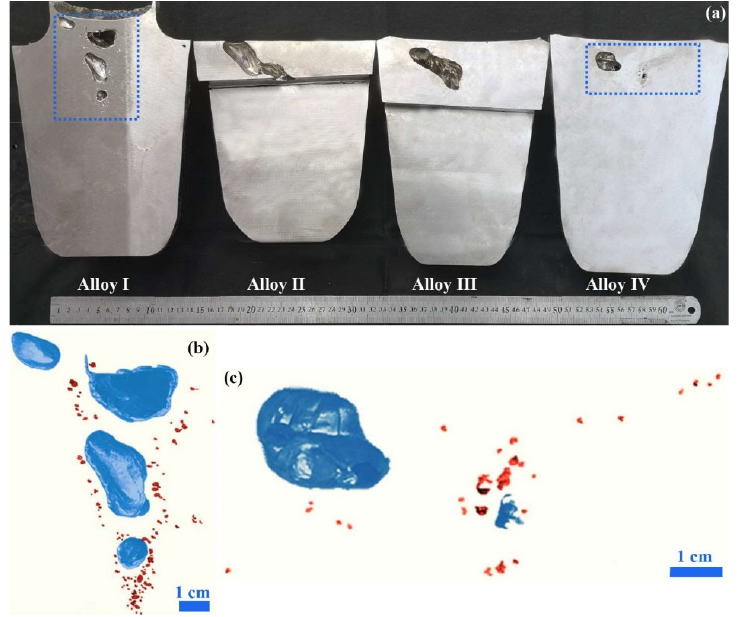
Figure 8. Shrinkage porosity of actual ingots ( a ) and local enlargement of ingot I ( b ) and IV ( c ).